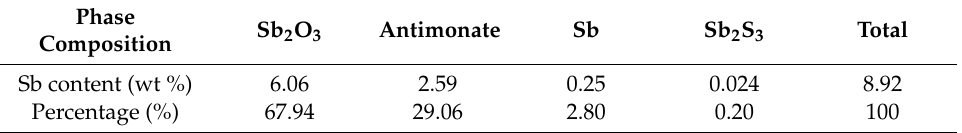
Table 2. Tin phase composition of the lead refining dross.